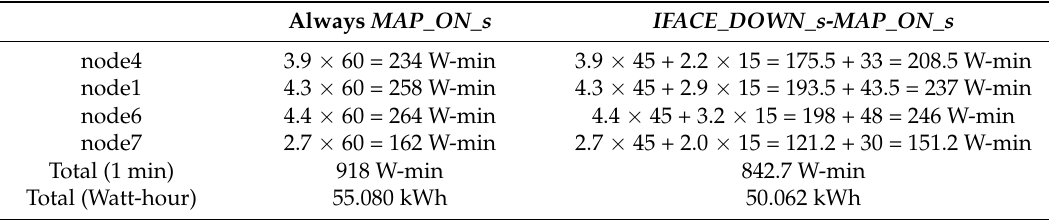
Table 10. Average-power comparative for always MAP_ON_s or cyclic changing, for T = 60